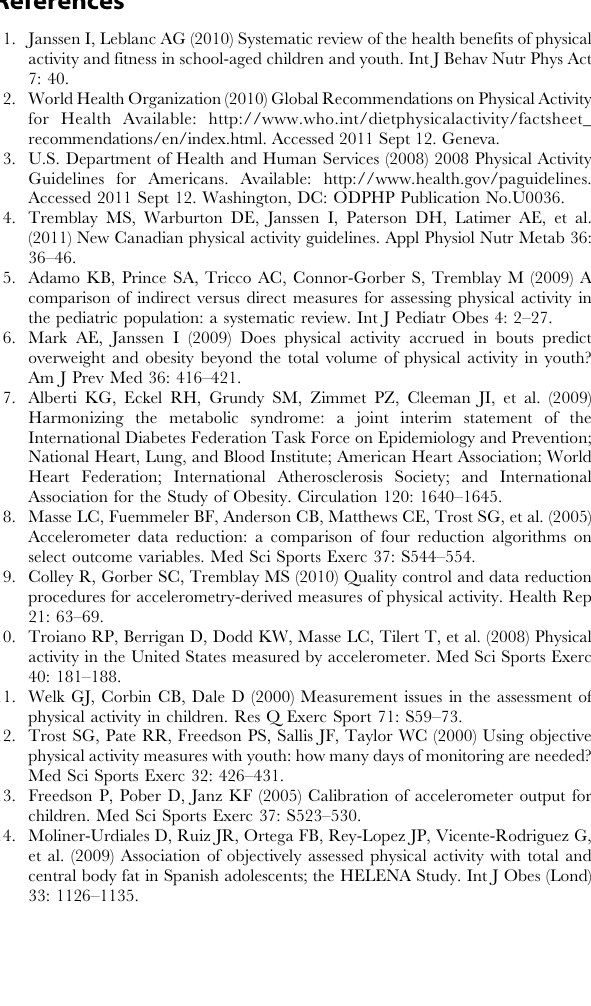
Table S1 Participant characteristics by gender and age. Data presented as median (inter-quartile range) for continuous variables or prevalence (%) for categorical